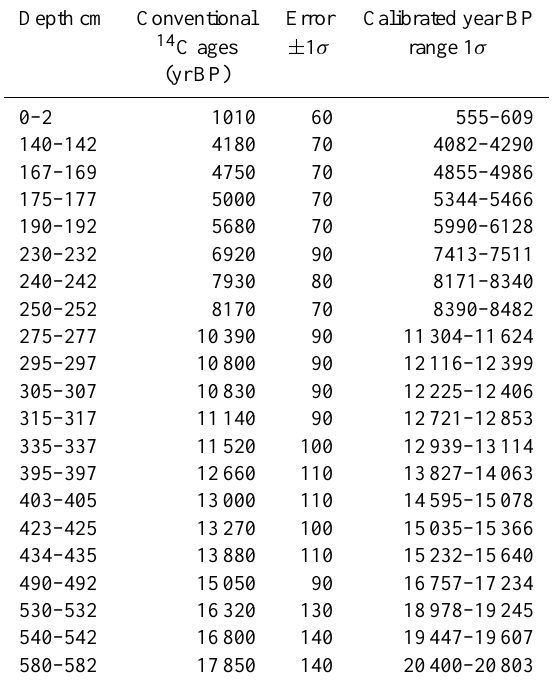
Table 2. Depth-age model for the MD90-917. Dates were calibrated using CALIB